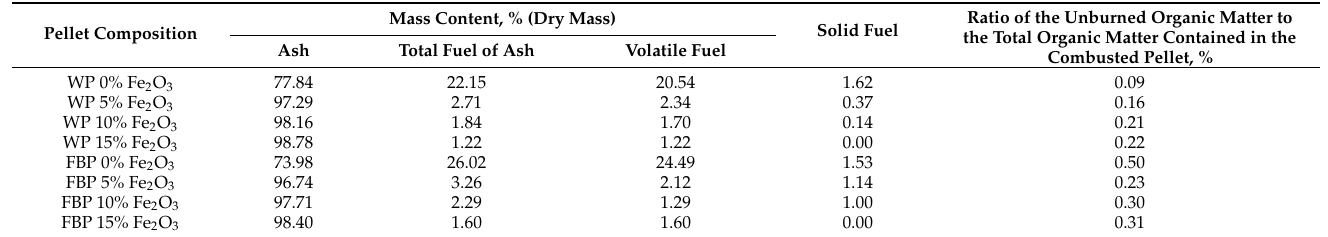
Table 10. Composition of ashes from the combustion of wood pellets (WP) and furniture board pellets (FBP) depending on the catalyst proportion (converted into dry